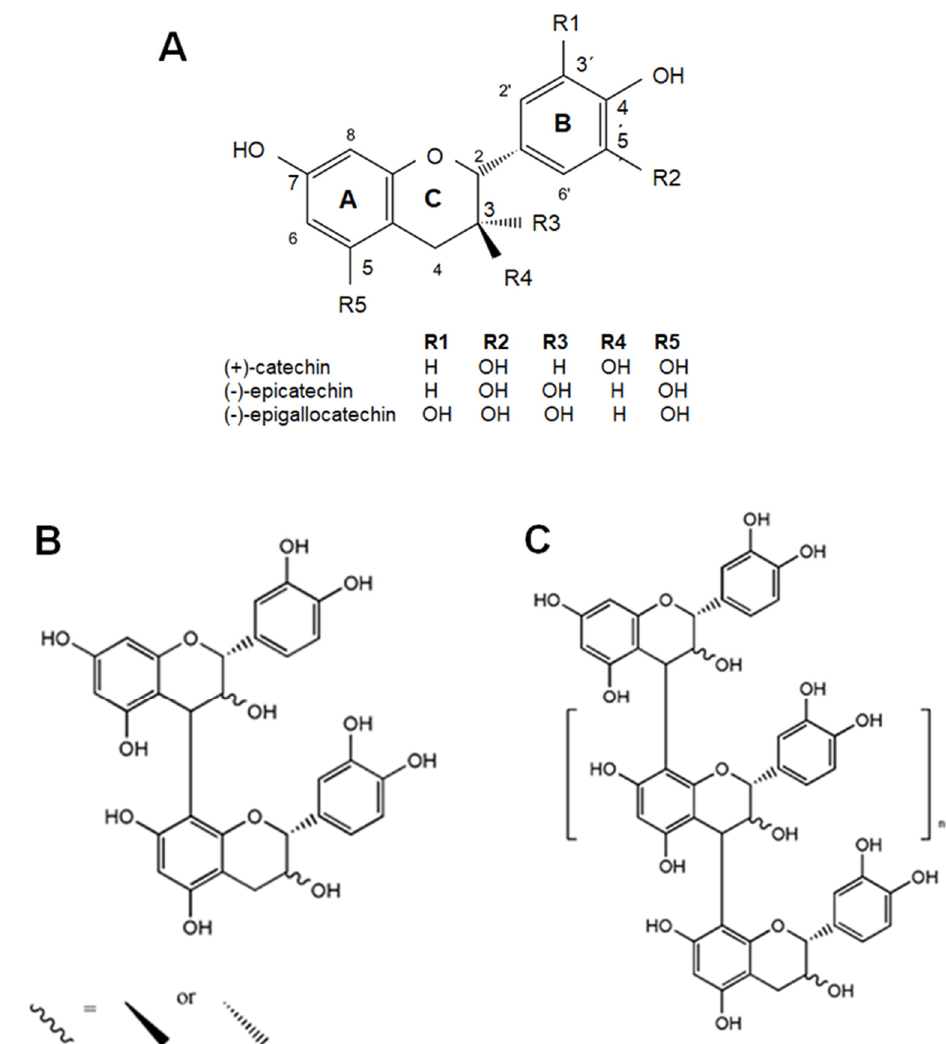
Figure 1. Chemical structure of main representative flavanols. ( A ) Flavanol monomers. ( B , C ) Procyanidins or proanthocyanidins.